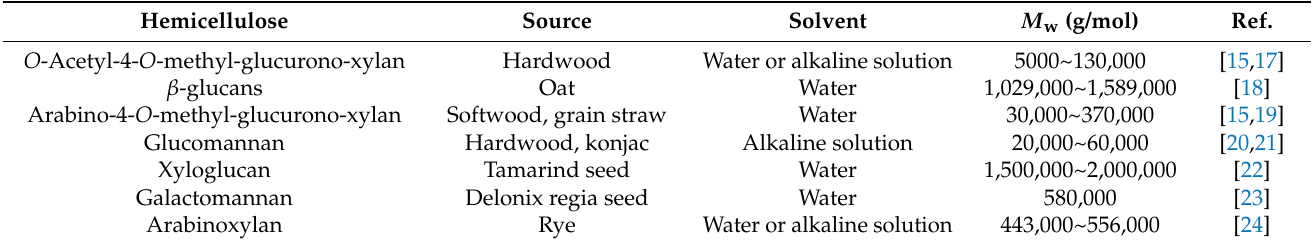
Table 1. Source, solvent and molecular weight of representative